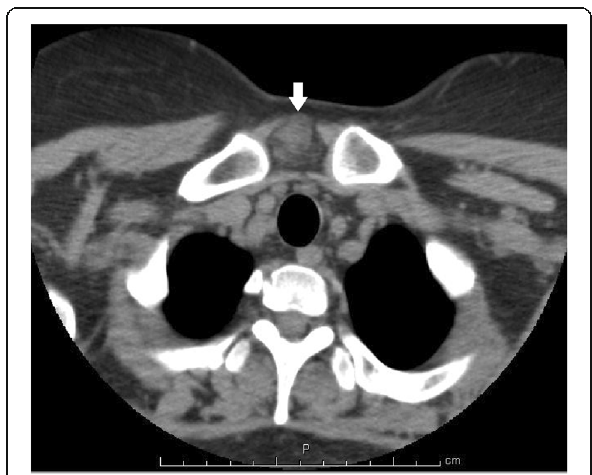
Fig. 1 The neck non-enhanced computed tomography scan revealed that the mass in the suprasternal subcutaneous tissue had the mixture components of soft tissue and fat density (arrow)